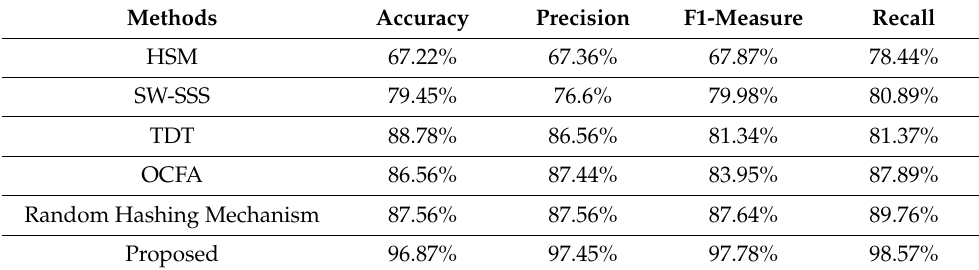
Table 3. Comparative study based on metrics for prediction diseases.